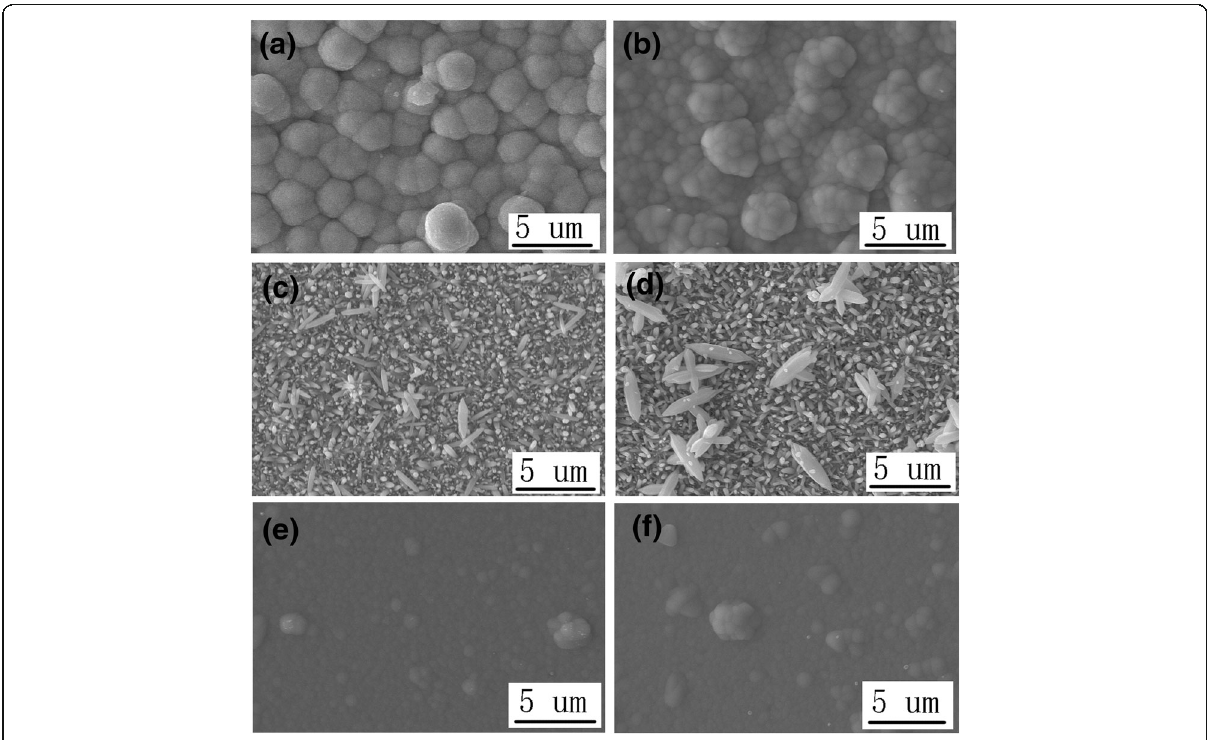
Fig. 3 The top view SEM image of ZnO/Cu 2 O (pH10, 20min) heterojunction ( a ), ZnO/Cu 2 O (pH10, 40min) heterojunction ( b ), Cu 2 O (pH10, 20min)/ ZnO heterojunction ( c ),